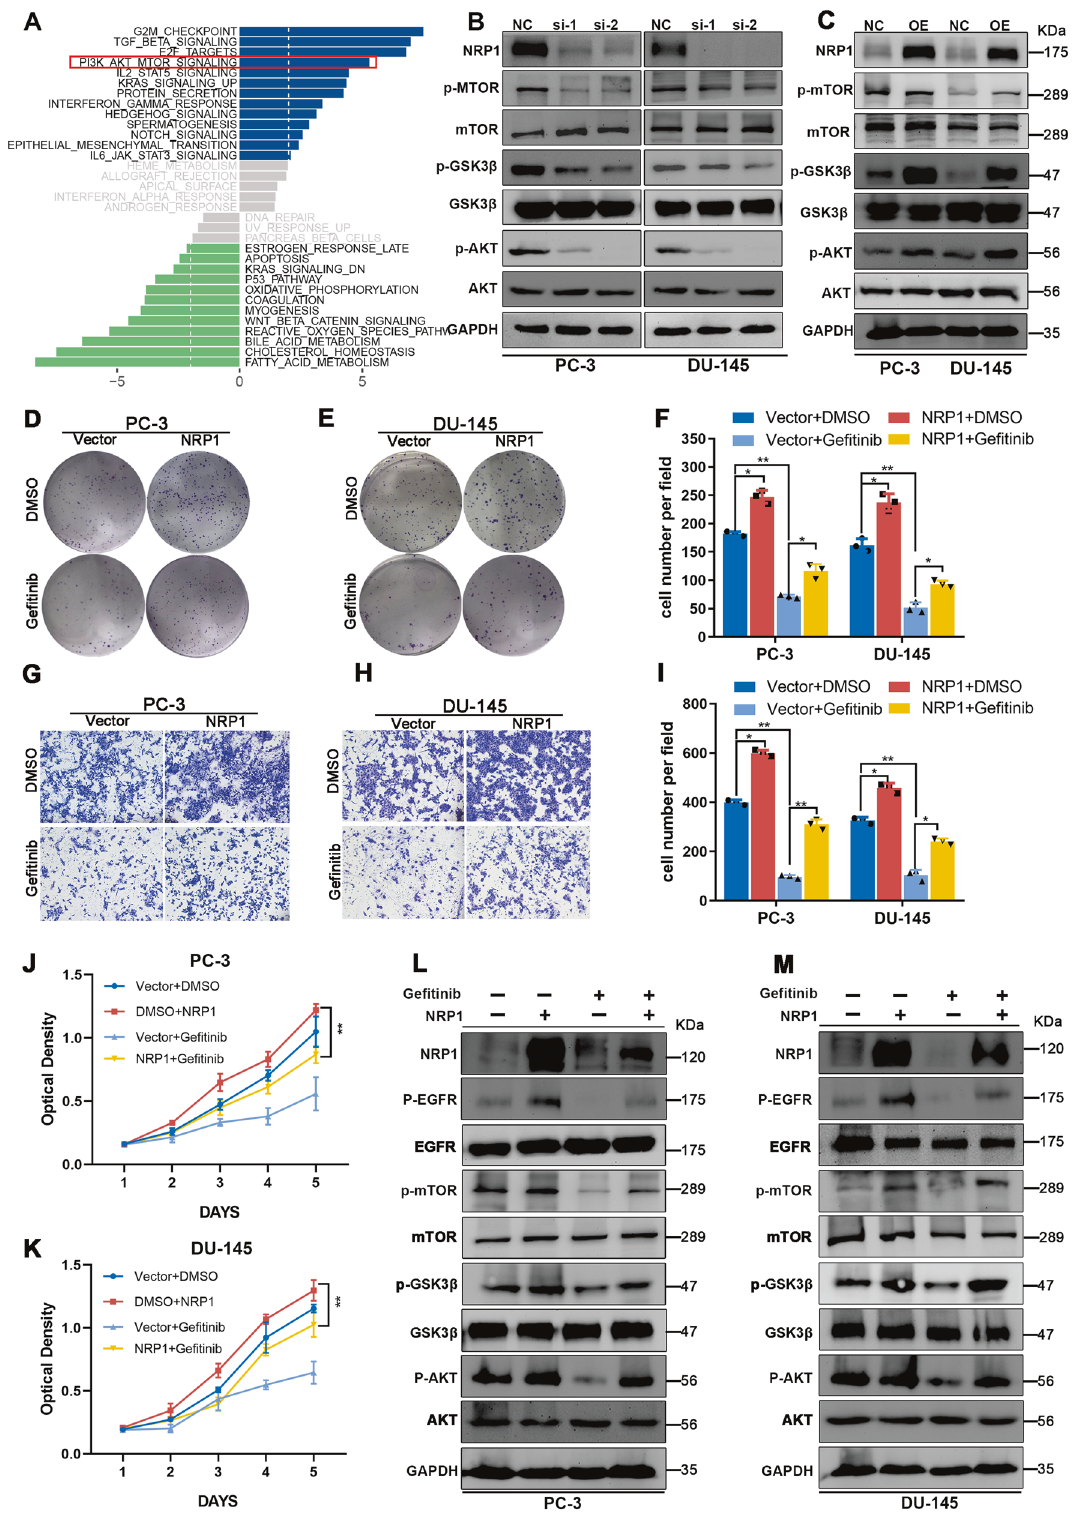
demonstrated that PCa cells treated with ge fi tinib inhibited the NRP1-induced EGFR/AKT signaling axis (Fig. 7L, M). Thus, these results exhibited that NRP1 promoted PCa progression by modulating the activation of the EGFR/AKT signaling